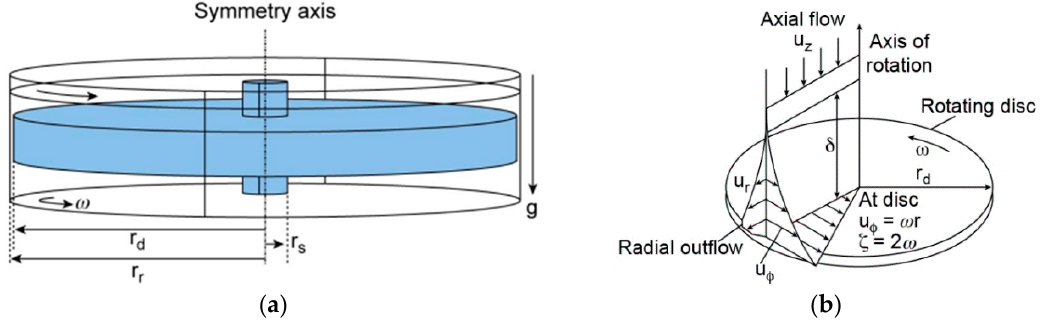
Figure 1. Schematic illustration of the reactor configuration and flow profiles: ( a ) RVR reactor, and ( b ) rotor-stator flow boundary layers showing the tangential velocity and vorticity amplitude profiles on the rotating disc (Reproduced from [8] with permissions © 2011 Elsevier).